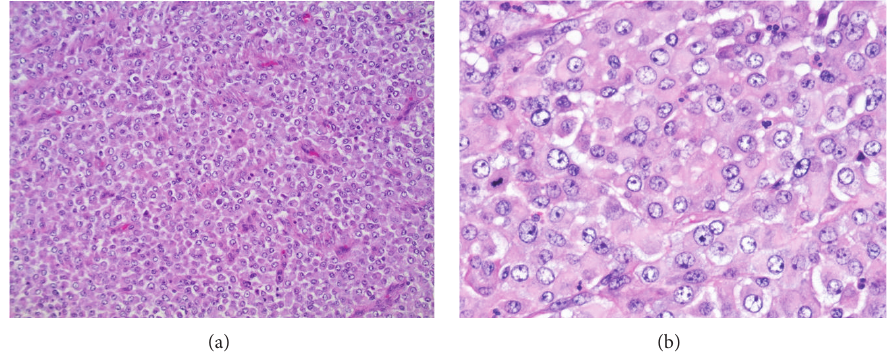
Figure 2: Microscopic examination of the retroperitoneal mass. There were sheets of undifferentiated cells with no papillary architecture seen ((a) 100x). The malignant cells had rhabdoid features with abundant granular eosinophilic cytoplasm, eccentric, vesicular nuclei, and prominent nucleoli. Mitoses were readily identified ((b)